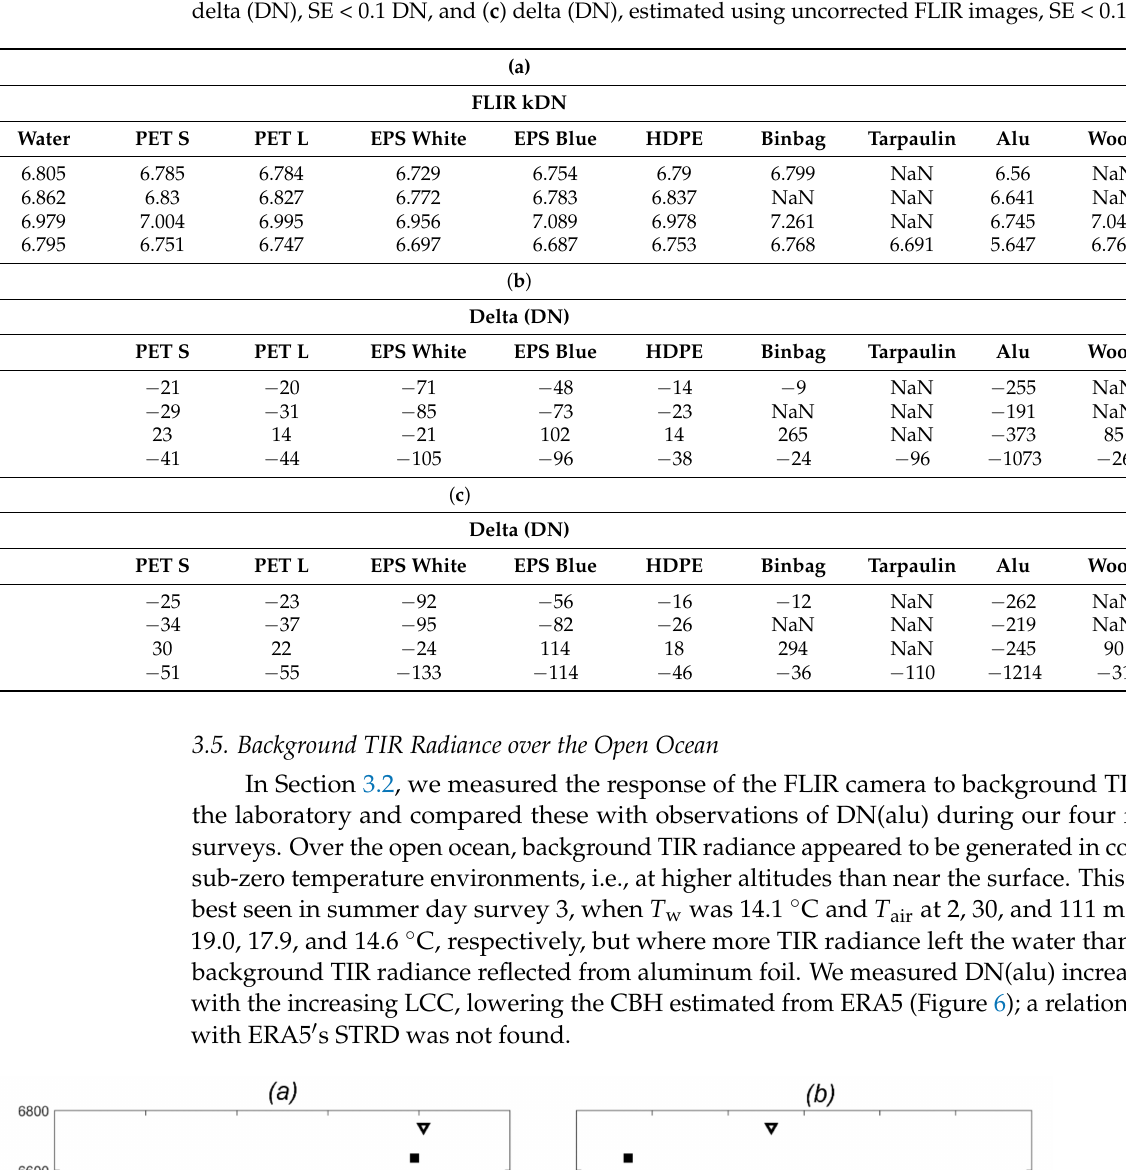
Table 6. ( a ) FLIR signal (kDN) for all imaged surfaces, obtained from survey “S”. Values are the means over 60 images ( a ) after flatfield correction with sigma = 30, SE < 0.001 kDN ( b ) concurring delta (DN), SE < 0.1 DN, and ( c ) delta (DN), estimated using uncorrected FLIR images, SE < 0.1 DN.